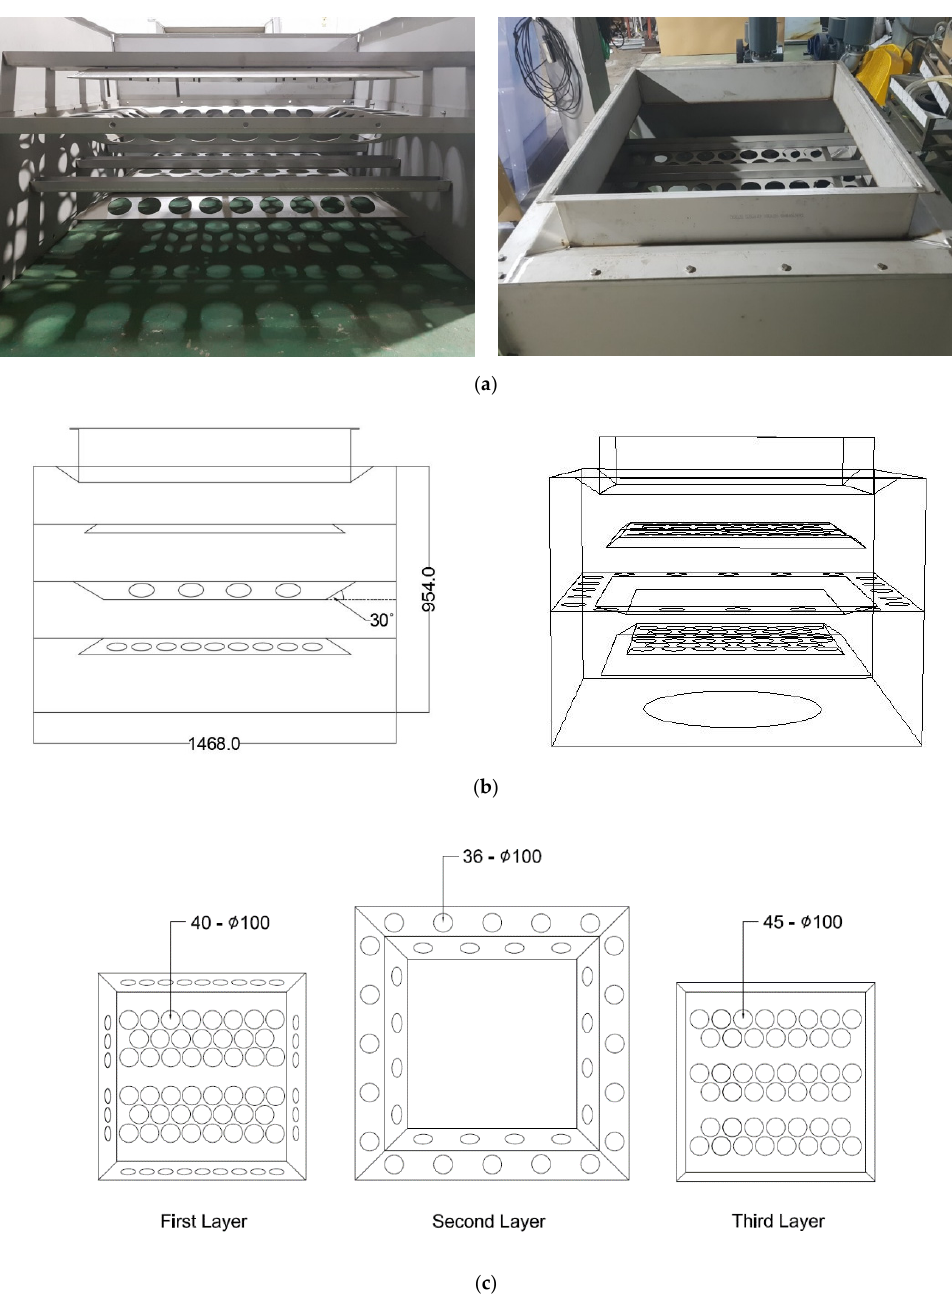
Figure 1. Pictorial view and schematic diagram of non-powered hydraulic mixing with three layers of ba ffl es and holes. ( a ) Pictorial view; ( b ) horizontal sectional view; ( c ) plan view of each